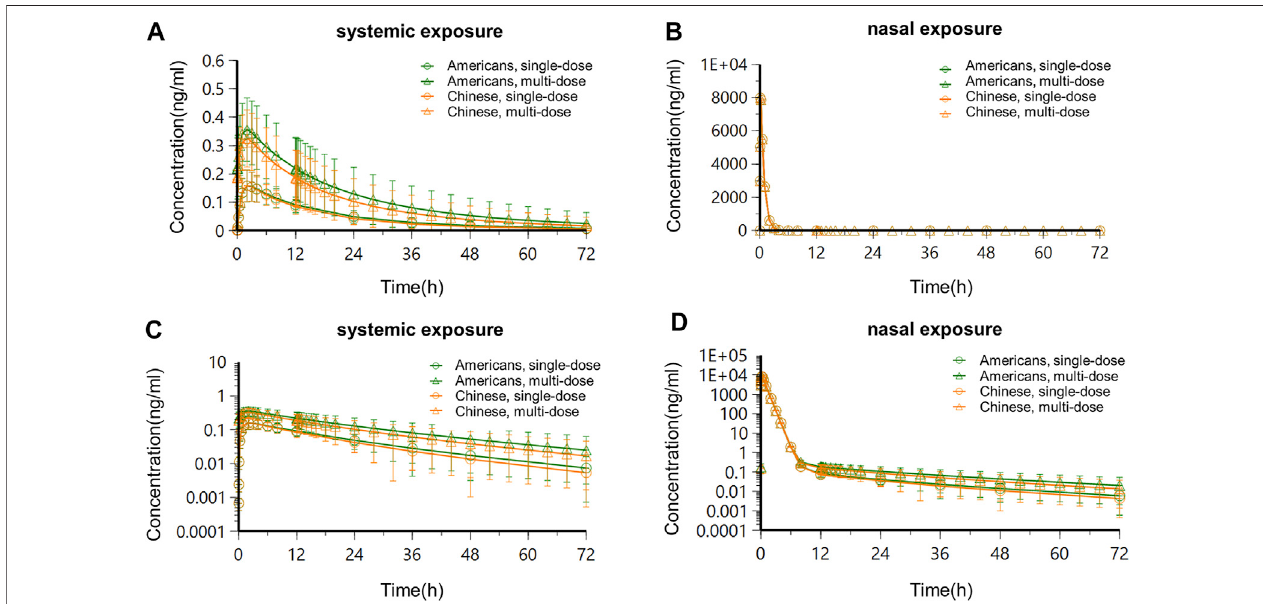
FIGURE 9 | Concentration – time curves in Americans and Chinese after the steady-state following single-dose administration and multidose administration. (A) Systemic concentration – time curve-constant scale; (B) nasal concentration – time curve-constant scale; (C) systemic concentration – time curve-semi-logarithmic scale; (D) nasal concentration – time curve-semi-logarithmic